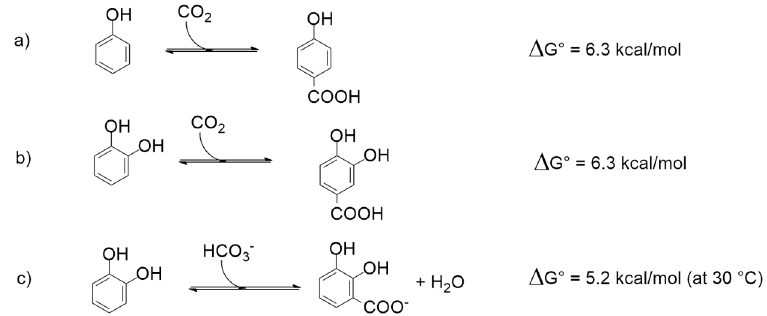
Figure 7. ∆ G ◦ for the carboxylation reaction of ( a ) phenol, and ( b , c ) catechol as calculated by Faber and coworkers.